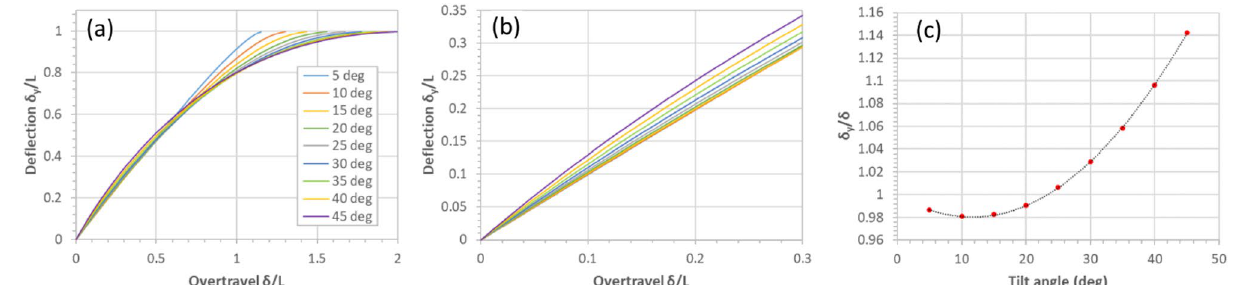
Figure 16. The relationship between overtravel and vertical deflection of the tip of a tilted triangular cantilever. ( a ) tip deflection as a function of imposed overtravel for various tilt angles. ( b ) the quasi-linear portions of the curves. ( c ) the tip deflection/overtravel ratio as a function of the cantilever tilt